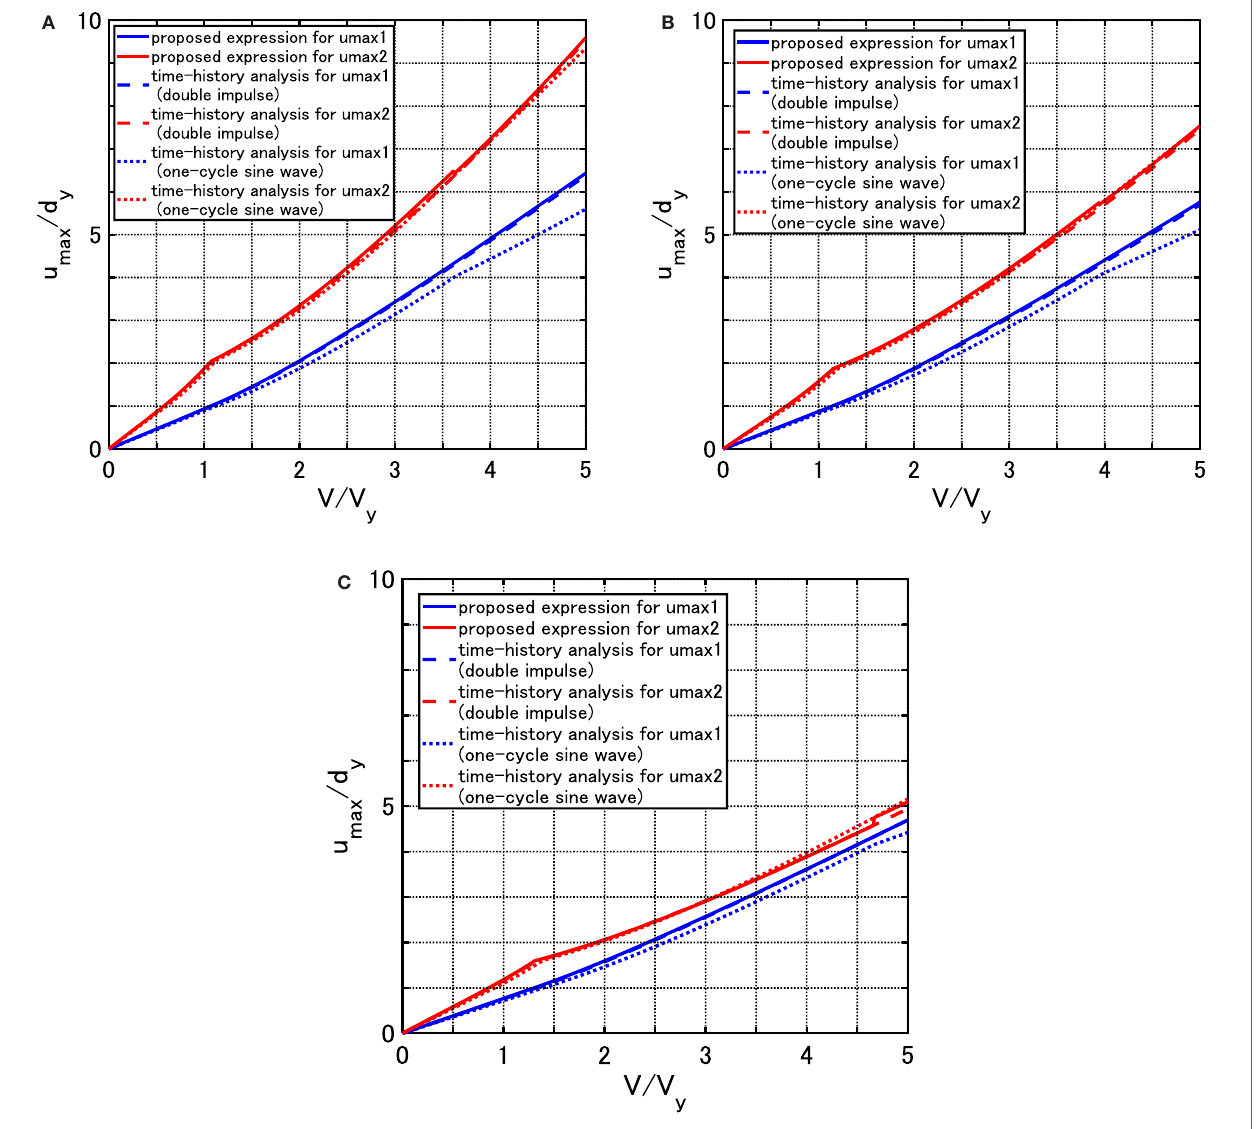
FIGURE 10 | Comparison of maximum deformations for model of α = 0.3 among proposed method, time-history response analysis under double impulse and time-history response analysis under corresponding one-cycle sine wave, (A) h = 0.05, (B) h = 0.1, and (C) h = 0.2.